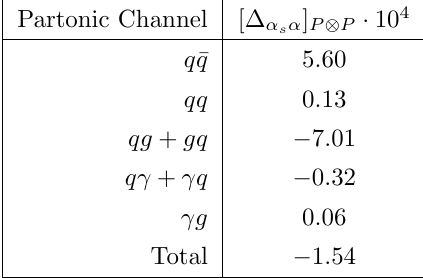
Table 1. Contributions of the di(cid:11)erent partonic channels to [(cid:1) (cid:11)